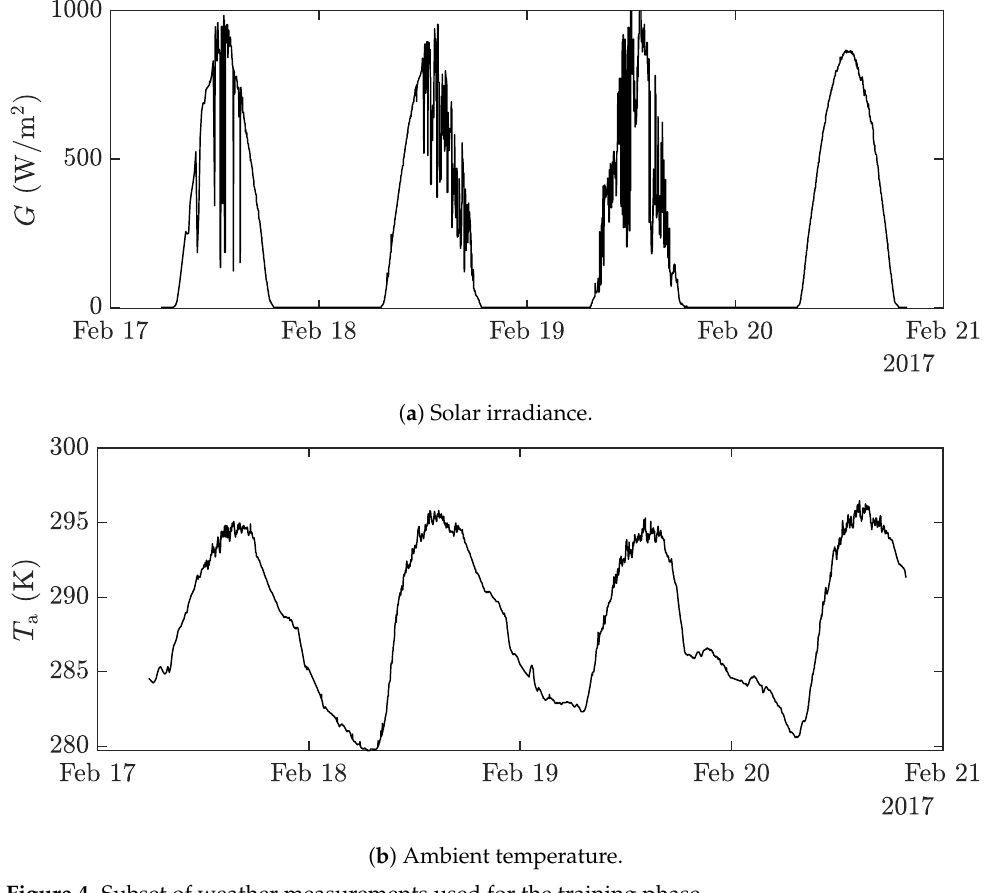
Figure 4. Subset of weather measurements used for the training